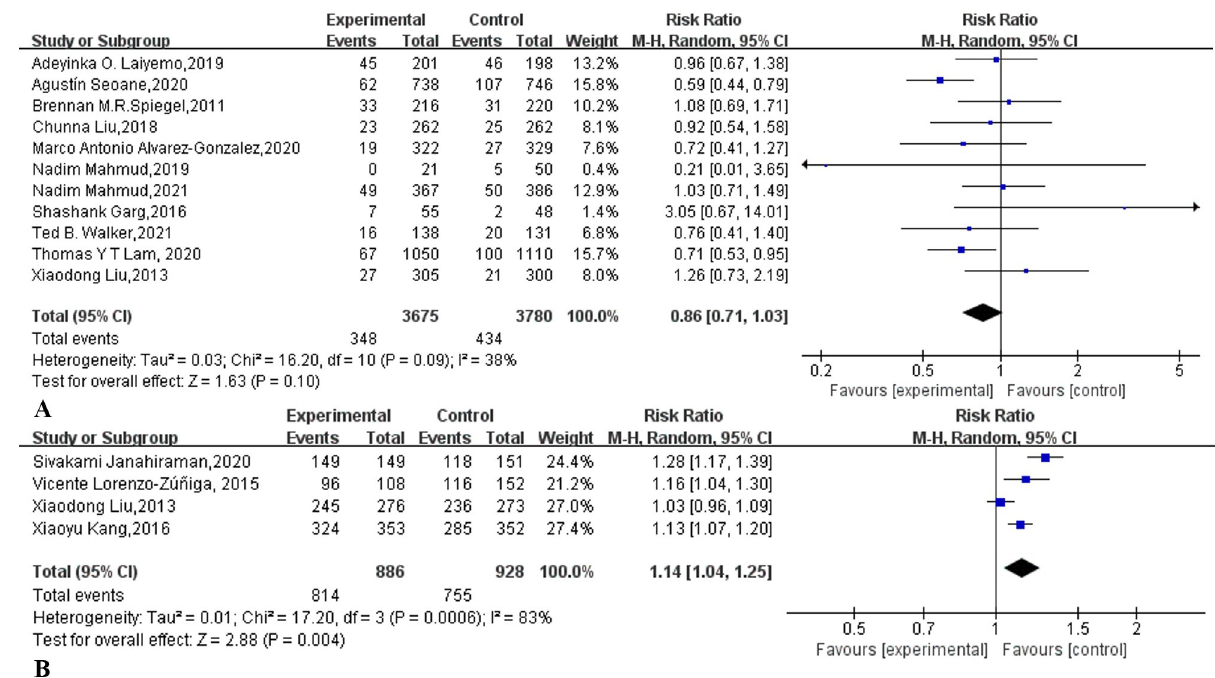
Fig 9. Forest plot comparing (A) nonattendance rate (NAR) and (B) willingness to repeat rate (WTRR) supplementary education combined with traditional education and traditional education alone.